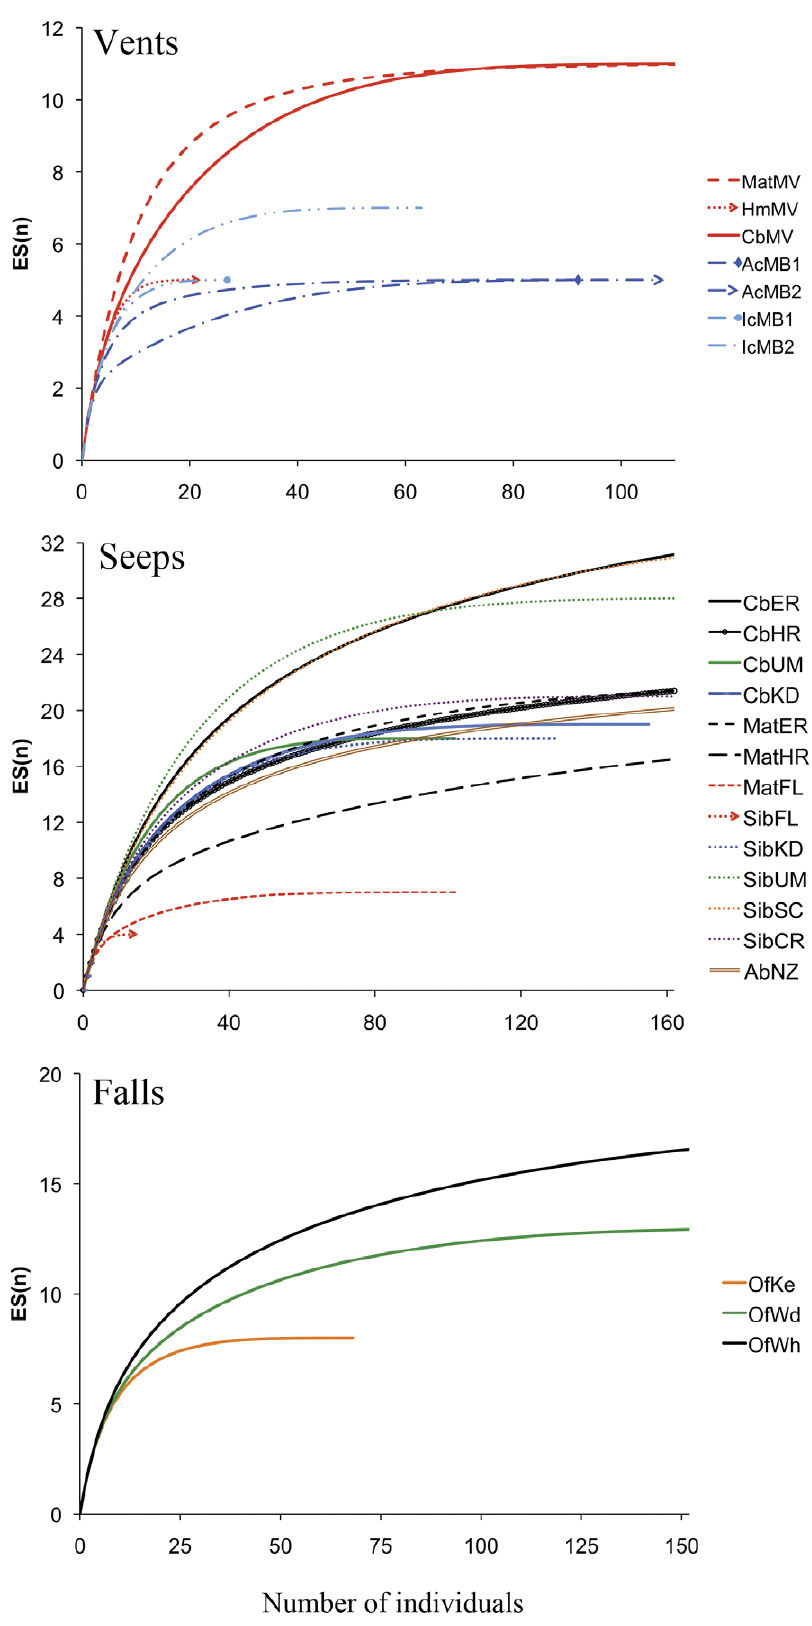
Figure 5. Rarefaction diversity at species level for vent (upper), seep (middle) and organic-fall (lower) habitats (cores pooled by site and habitat). Colors indicate sites; Line patterns differentiate habitats within sites. Legend: Mat – microbial mats, Cb – clam beds, Sib – frenulate fields, Ab – ampharetids beds, Ac – active vent sediments, Ic – inactive vent sediments, Hm – vent hot muds, Of – organic-falls. Sites: MV – Middle PLoS ONE |